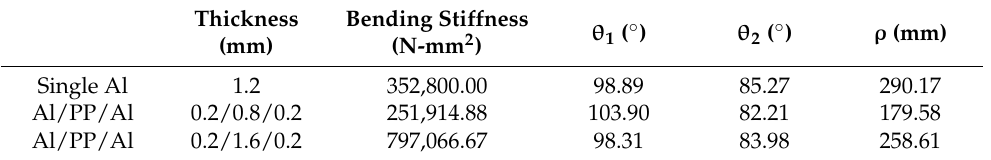
Table 6. Comparison of springback angles and radius of curvature of U-channels of a single alumi- num sheet and two Al/PP/Al sandwich laminates.